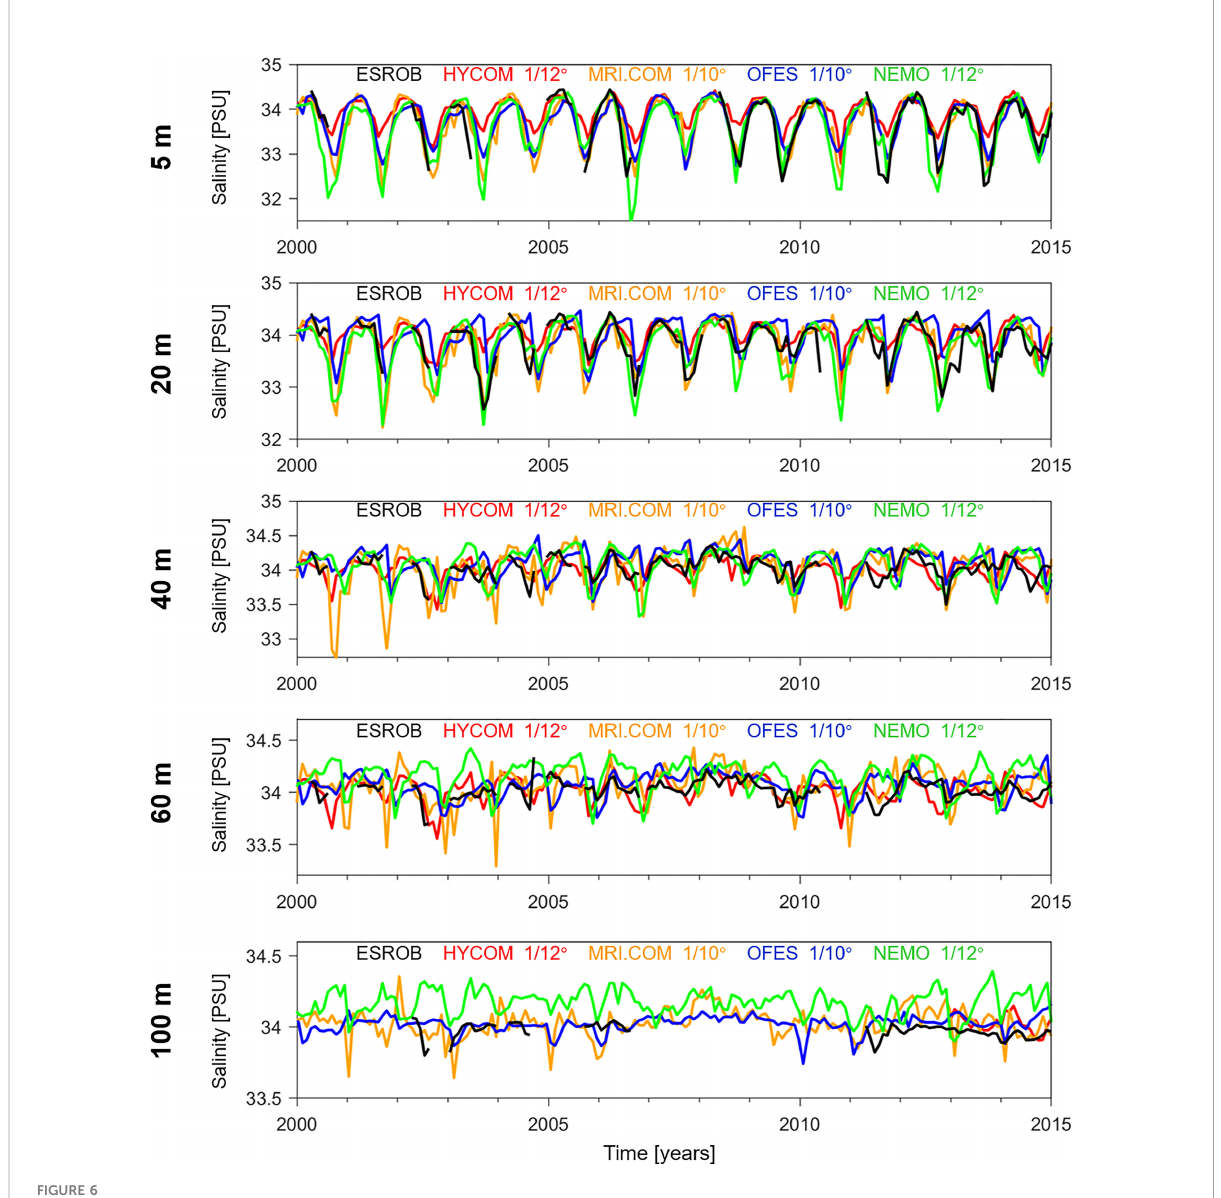
FIGURE 6 The same as Figure 5 but for the monthly mean